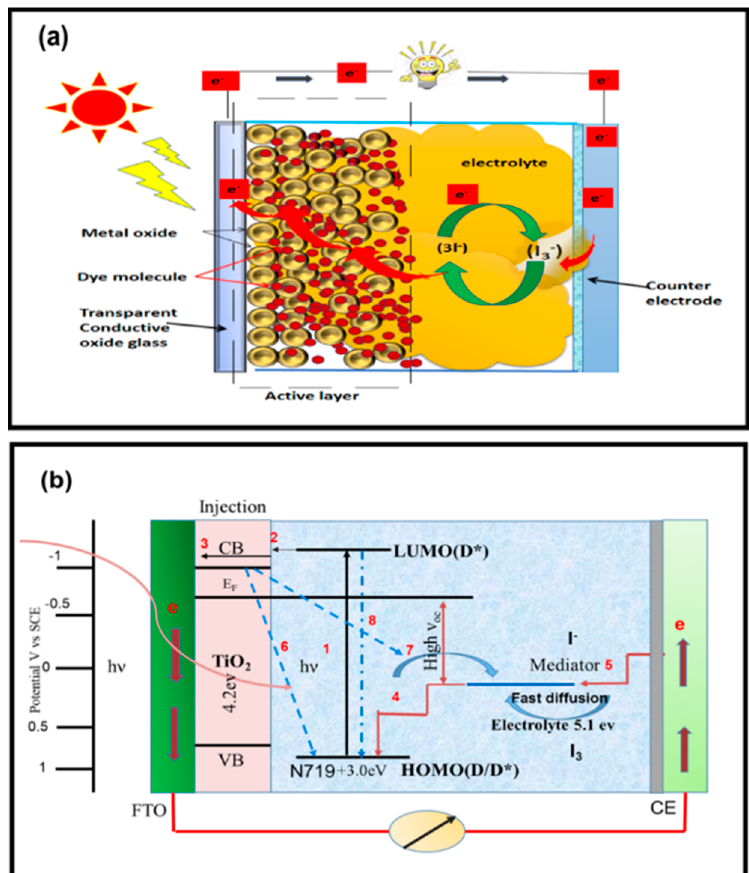
Figure 2. ( a ) Fundamental processes and constituent components of DSSCs. ( b ) Working principle and electron flow process of DSSCs.